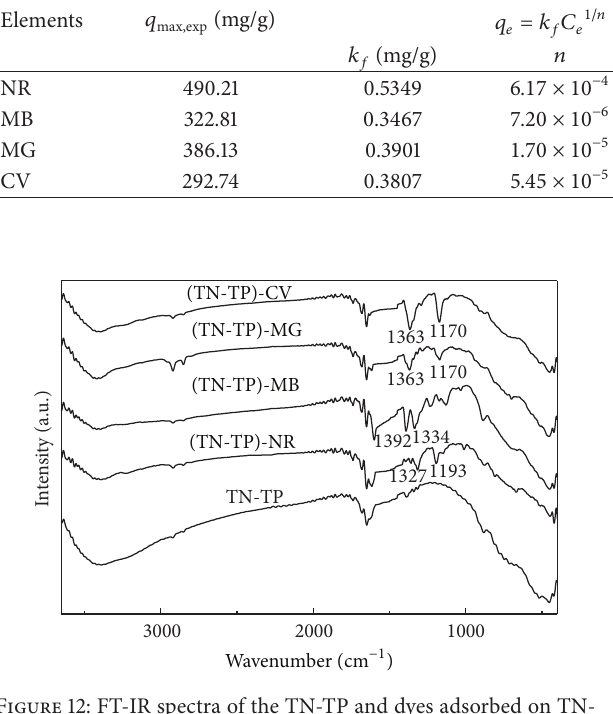
Figure 12: FT-IR spectra of the TN-TP and dyes adsorbed on TN-